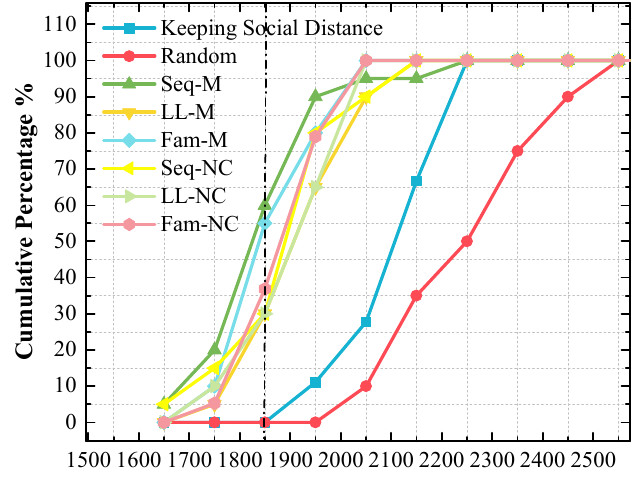
Figure 8. The cumulative frequency of cumulated confirmed cases using various strategies in the 1st scenario. The x-value of the dash line is 1850.